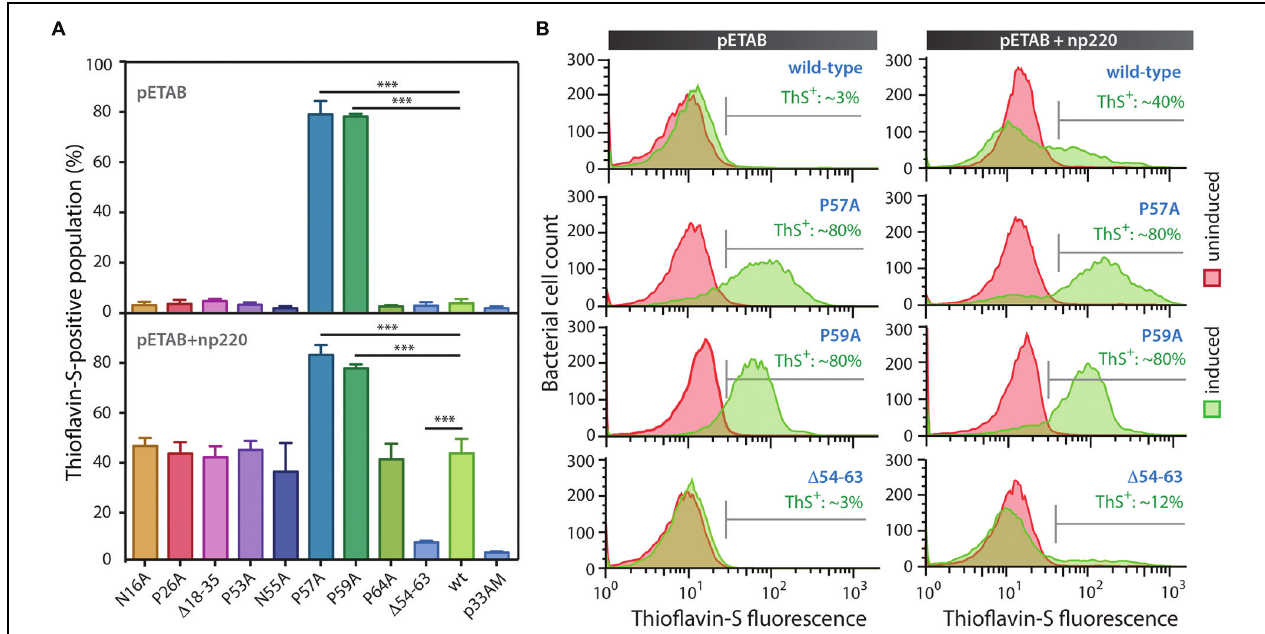
FIGURE 4 | MccE492 region 54–63 and residues P57 and P59 control in vivo amyloid formation. MccE492 mutants of putative gatekeeper residues or lacking predicted aggregation hotspots were expressed in E. coli BL21-AI cells, followed by ThS staining. Bacterial cell populations carrying MccE492 amyloid inclusions (ThS-positive) were quantitated by flow cytometry. (A) ThS-positive population frequency upon expression of different MccE492 variants in the absence (top), or co-transformed with np220 (bottom). (B) Representative histograms of flow cytometry data obtained for cells expressing wild-type MccE492 or variants with altered aggregation propensity, either in the absence or co-transformed with np220. Error bars show the standard deviation from three independent experiments. ∗∗∗ p < 0.0001. An average of 10000 events were counted per flow cytometry run. p33AM is the vector in which the cassette pETAB was